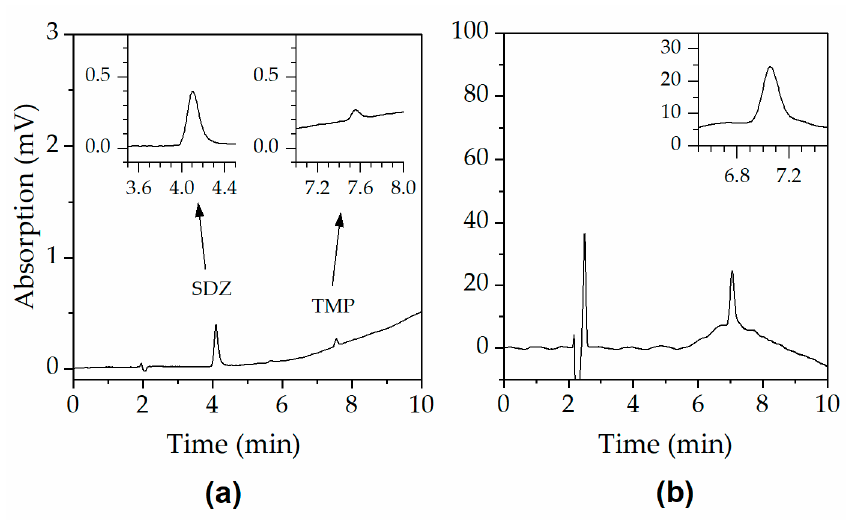
Figure 4. UV-chromatograms at the lowest calibration level of all compounds under investigation: ( a ) SDZ 0.05 µg mL − 1 , TMP 0.005 µg mL − 1 , and ( b ) AMO 0.5 µg mL − 1 .